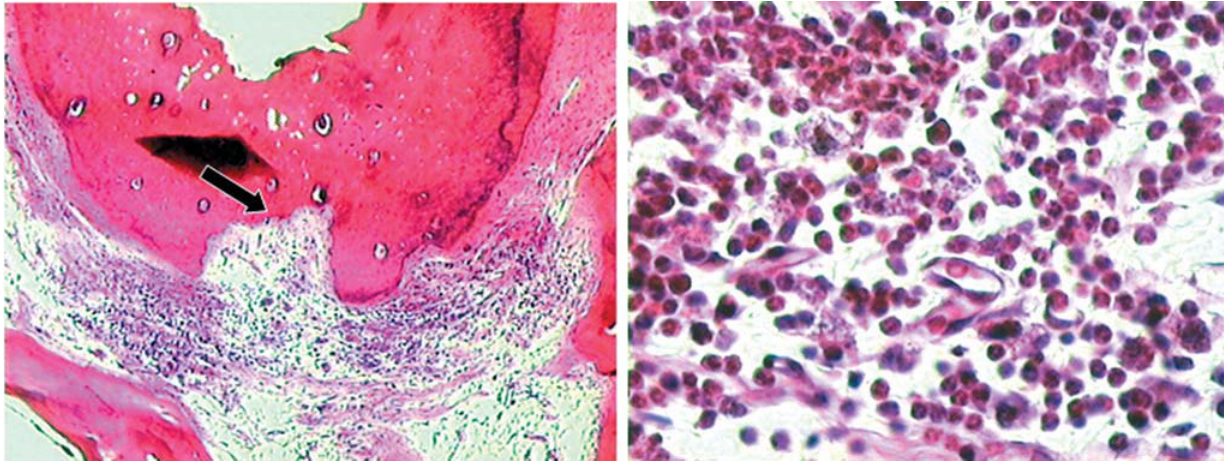
FIGURE 4 - A - SEM micrograph of apical and periapical regions of a specimen in the control group. Note inflammatory infiltrate along apical periodontal ligament. Areas of apical cementum and dentin resorption can be seen (arrow), as well as resorption of adjacent bone. HE. 40X. B - Close-up view. Intense neutrophil infiltrate with some dead cells and resulting in pus formation, compatible with score 4 of AIR. HE. 400X